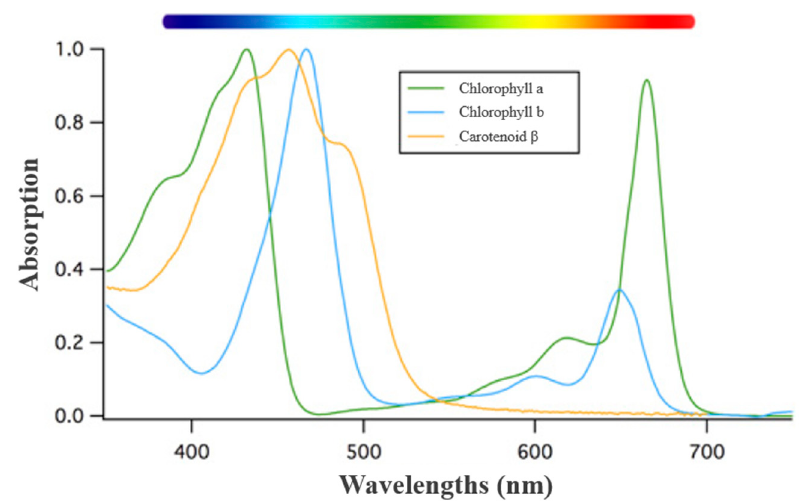
Figure 12. Basic absorption spectra of crops’ main chlorophyll and carotenoid pigments [103]. Indeed, wavelengths from 430 to 500 nm are effective in chloroplast development and photosynthetic function [106,108]. In addition to promoting photosynthetic activity, wavelengths from 640 to 670 nm are necessary for leaf growth and crop biomass production [106,109]. Furthermore, according to Wang and Folta [110], the wavelengths 500–600 nm are of great importance in chlorophyll content, photosynthetic function, and consequently crop growth. This part of the solar radiation of wavelength 400–700 nm is called photosynthetically active radiation and represents the part of solar radiation mainly used for photosynthe- sis [111,112]. However, the total proportion of solar energy in the photosynthetically active band represents only 48.7% of the average solar spectrum measured at the Earth’s surface. At the same time, the chlorophyll pigment is considered as an imperfect radiation